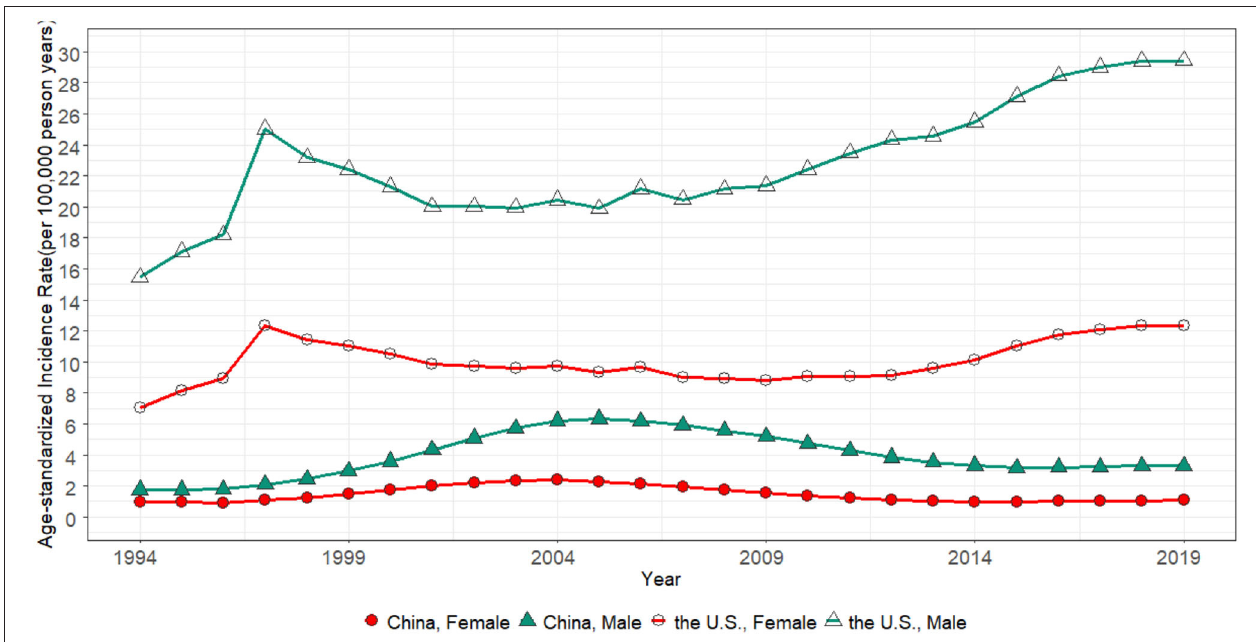
FIGURE 1 | The age-standardized incidence rate for China and the U.S. from 1994 to 2019.